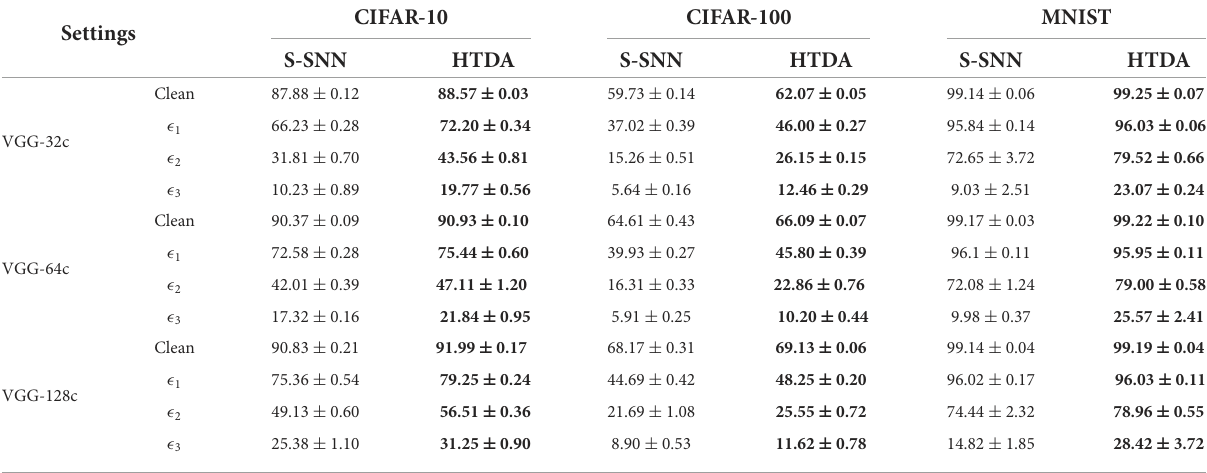
TABLE 1 Comparison of accuracy and robustness under different settings (%).